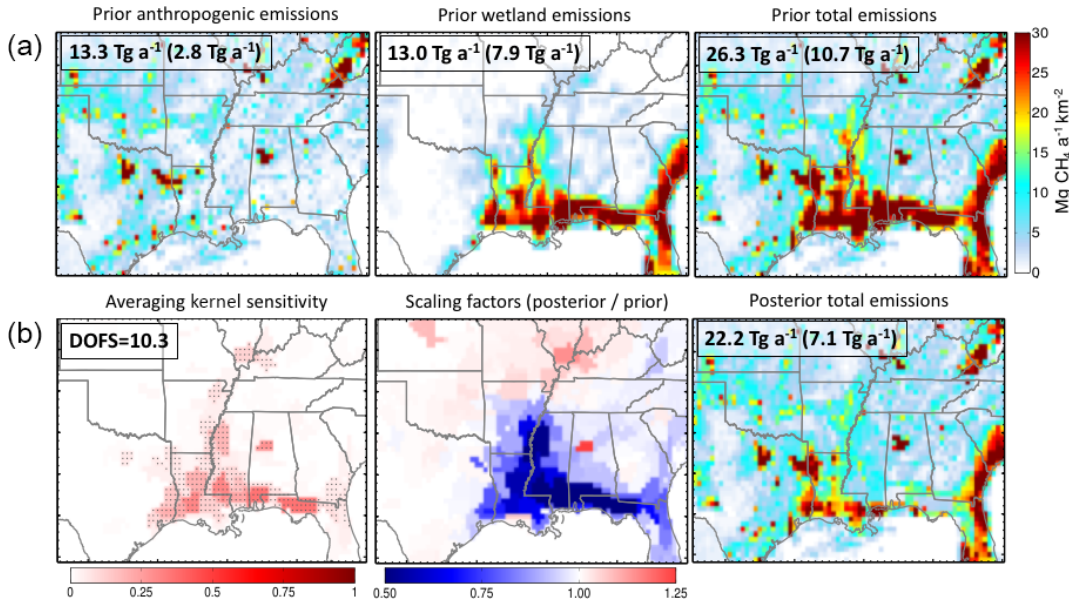
Figure 1. Methane emissions in the Southeast US in August–September 2013. Panel (a) shows the prior anthropogenic and wetland methane emissions, and panel (b) shows the inversion results including posterior emissions, scaling factors (posterior / prior emission ratios), and the diagonal elements of the averaging kernel matrix representing the sensitivity of the inversion results to the observations. The sum of these diagonal elements over the domain (trace of the averaging kernel matrix) quantifies the degrees of freedom for signal (DOFS) of the inversion. Numbers inset in the emission panels are the regional totals expressed as annual means for clarity (i.e., assuming that August–September emission rates hold for the rest of the year). Values in parentheses are the totals for the region with averaging kernel sensitivities larger than 0.05 (stippled areas in lower left